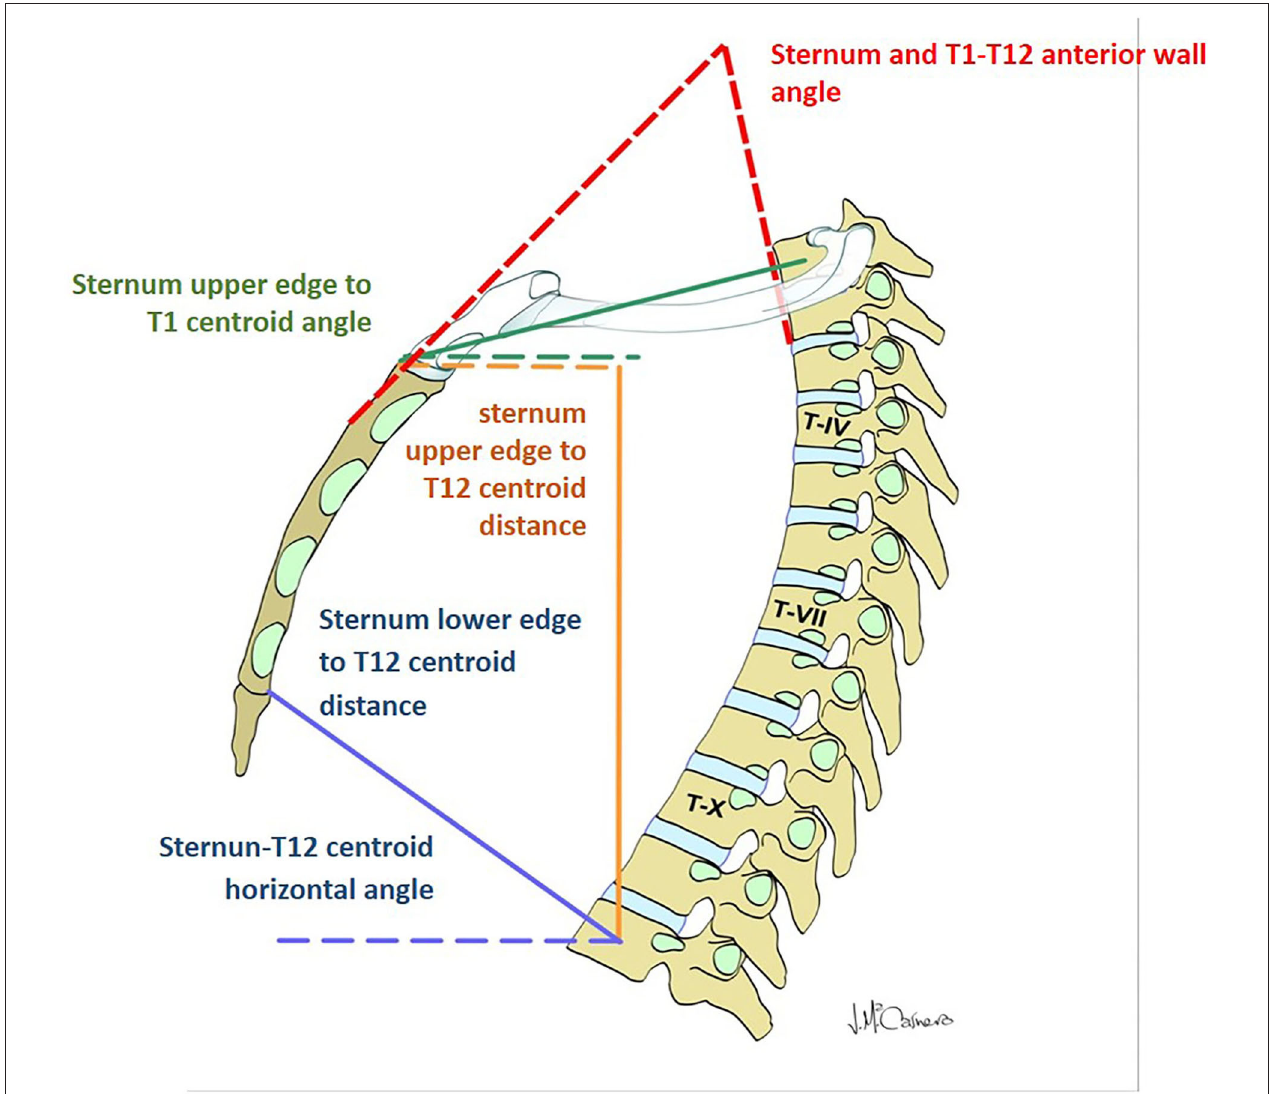
FIGURE 2 | Parameters evaluating the displacement of the thoracic spine with respect to the sternum and manubrium.